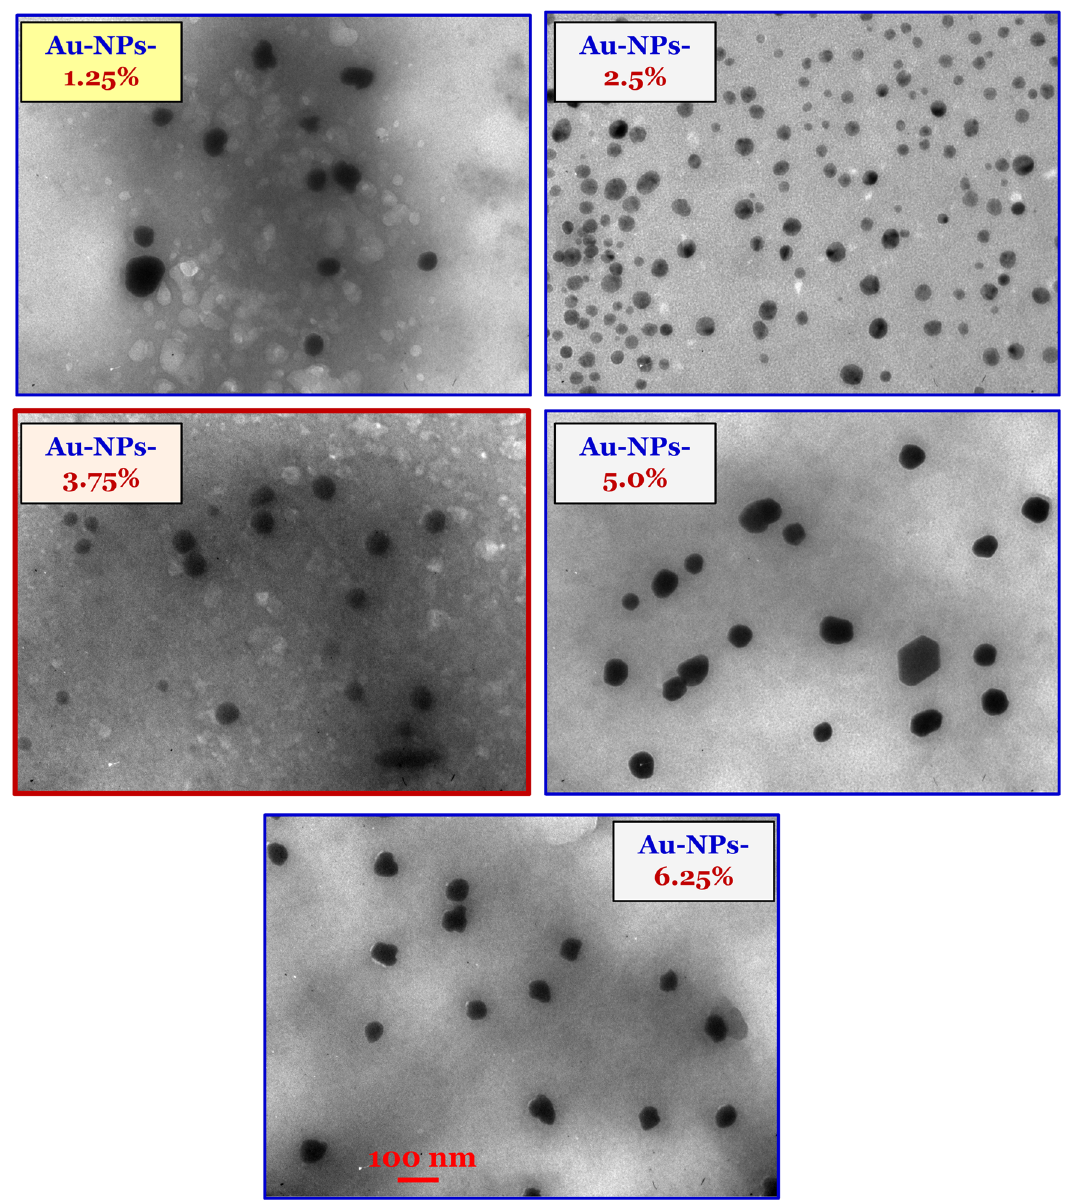
Figure A2: TEM images of Au - NPs prepared at di ff erent ratios of the extract